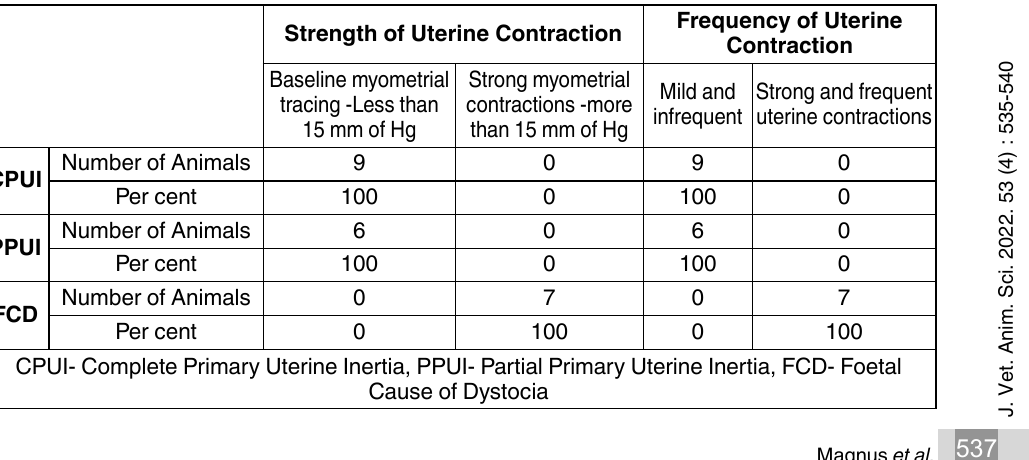
table. 1. Non-invasive uterine contraction monitoring with Tocodynamometry in canine uterine inertia Frequency of Uterine strength of Uterine contraction contraction Baseline myometrial Strong myometrial Mild and Strong and frequent tracing -Less than contractions -more infrequent uterine contractions 15 mm of Hg than 15 mm of Hg Number of Animals 9 cPUi Per cent Number of Animals PPUi Number of FcD